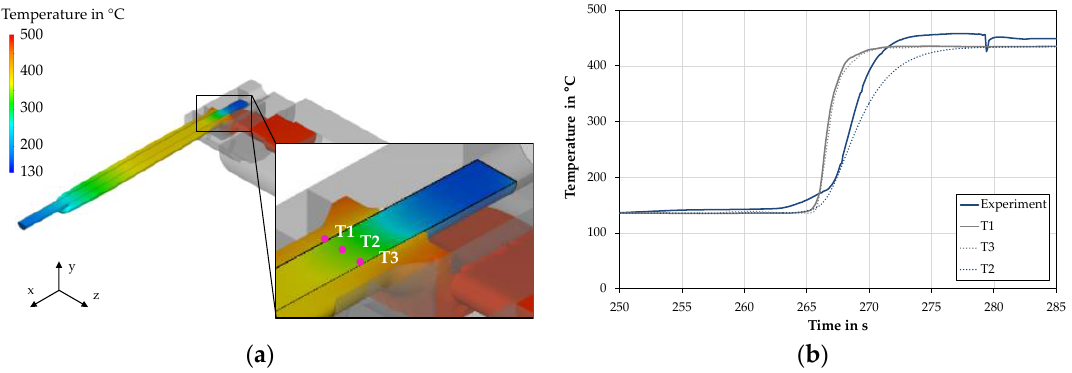
Figure 10. ( a ) Calculated temperature distribution during extrusion and highlighted temperature measurement points T1–T3; ( b ) Comparison of the calculated temperature curves at measurement points T1–T3 with the experimental results.